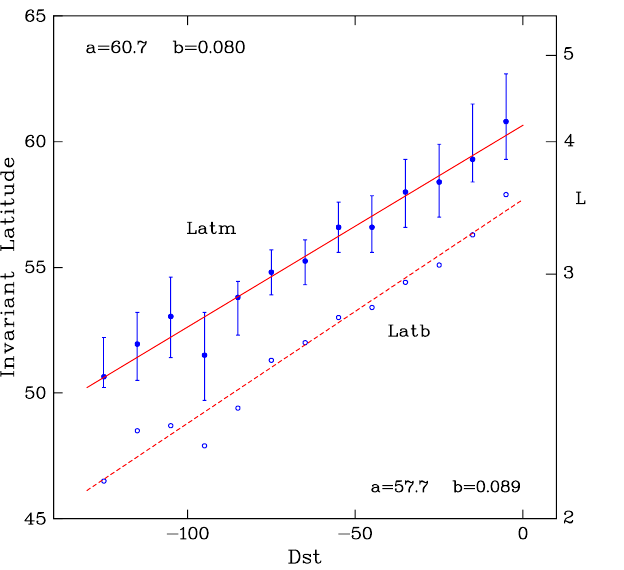
Fig. 4. Position of the subauroral electron temperature enhancement as a function of geomagnetic activity. The Dst index is indicated on the abscissa, the invariant latitudes ( L -shells) of the associated equatorward boundaries ( latb ) and maxima ( latm ) of the temper- ature enhancements on the ordinates. The median and the upper and lower quartiles of these parameters were determined for each 10nT-wide interval of the Dst index. In the case of latm , these are indicated by the blue dots and bars. In the case of latb , only the respective medians are shown (open blue circles). Linear regres- sion lines were fitted to the median values ( latm : solid red line; latb : dashed red line). The associated ordinate intersections a (in degrees) and slopes b (in degrees/nT) are given in the upper left- hand ( latm ) and lower right-hand ( latb ) corners, respectively. In both cases the correlation coefficient is greater than 0.98.